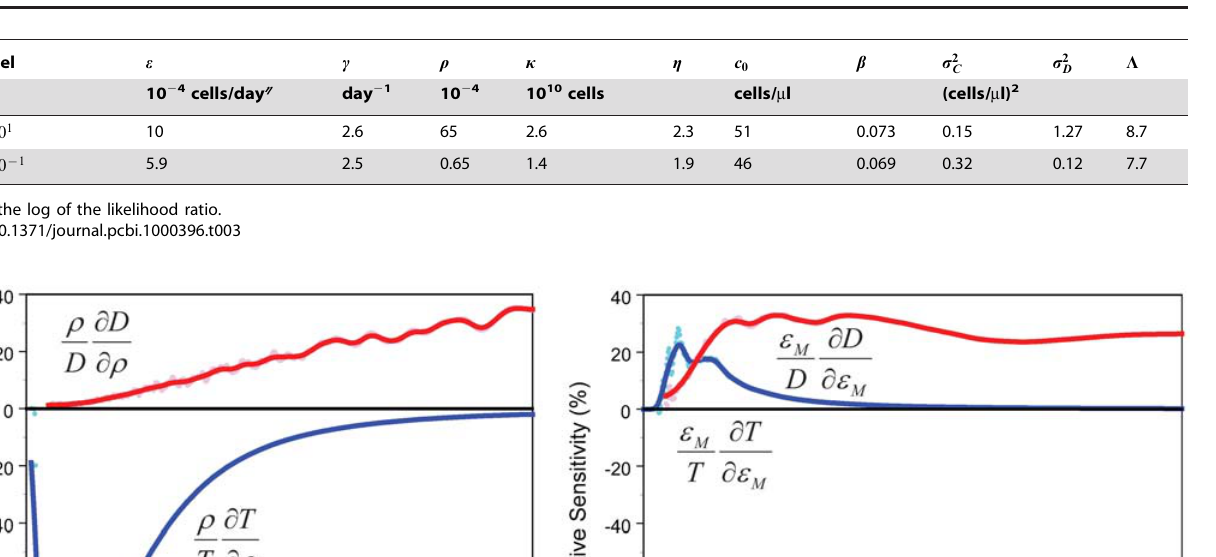
Table 3. Maximum-likelihood estimates in the constrained model with fixed r .